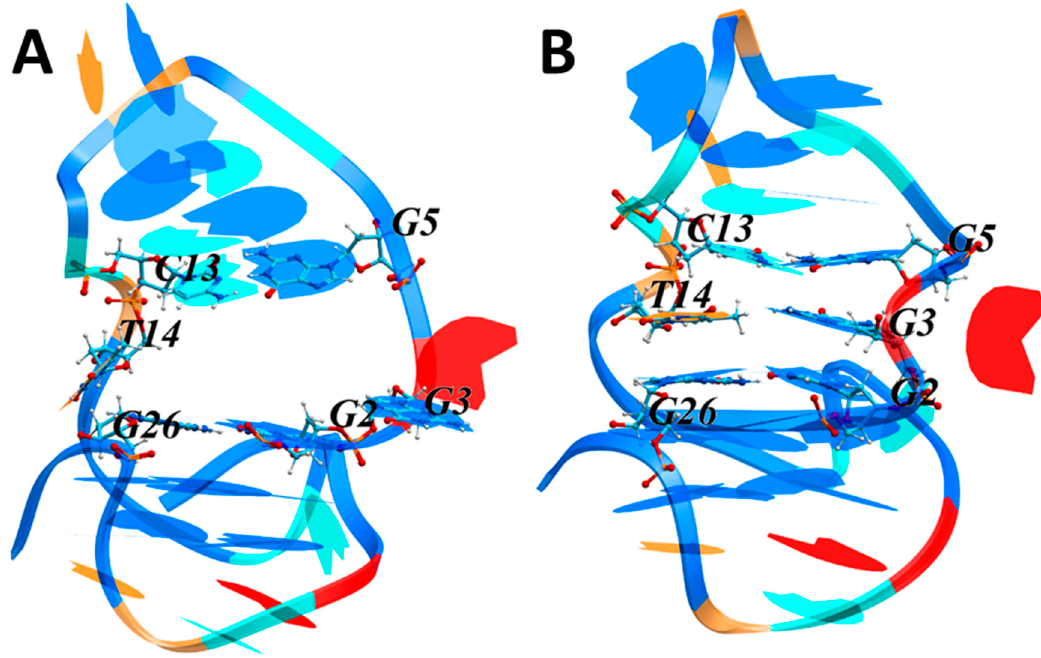
Figure 5. LTR-III G4 structure at the initial, 0 ns ( A ) and final, 80 ns ( B ) stages of MD simulations. The DNA shown by rendering with the nucleotides are colored as follows: G, blue; A, red; T, light brown; C, cyan. Cavity-forming nucleotides are in ball-and-stick representation. Atoms are represented by the following colors: carbon, ice blue; oxygen, red; nitrogen, blue; and hydrogen, white.